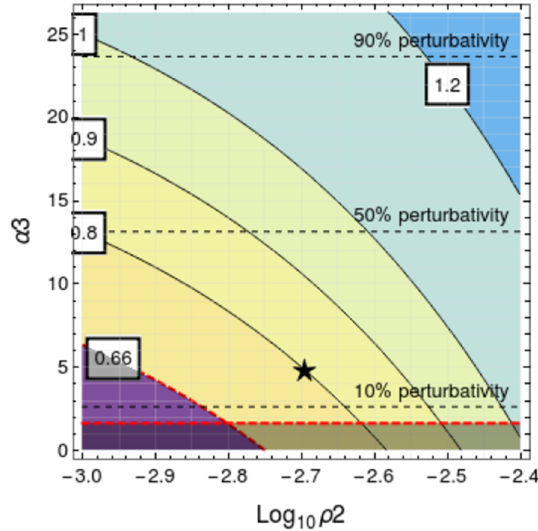
Figure 1. The mass of δ ±± (in TeV) as a function of the potential parameters α 3 and log ρ 2 , 10 R with M W = 5 . 2 TeV . The contour plot is divided into mass regions shown in the legend. The R shaded regions are excluded by FCNC constraints (the region under the lower horizontal dashed red line) and by direct LHC searches (the region left to the dashed red contour). The dashed black lines denote the α 3 perturbativity percentage. The point marked by F corresponds to a parameter set used in the signal search of section 4 ( M W = 5 . 2 TeV , M = 0 . 8 TeV , α 3 = 4 . 8 δ ±± R R